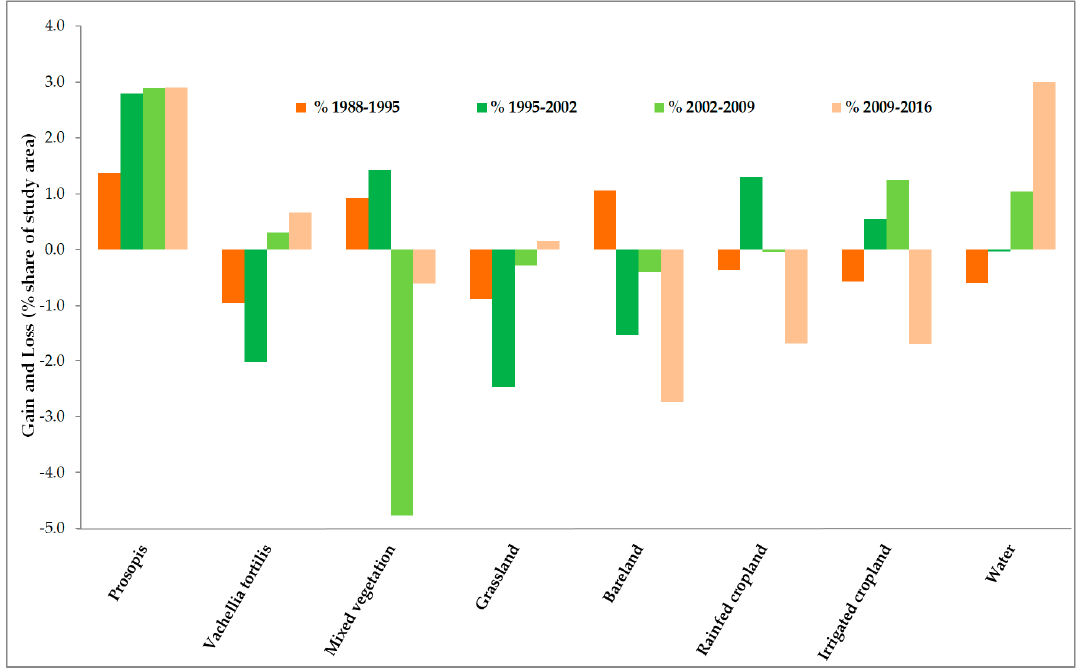
Figure 4. The gain and loss of each LULC in percent shares of the total study area for 1988–1995, 1995–2002, 2002–2009, and 2009–2016.